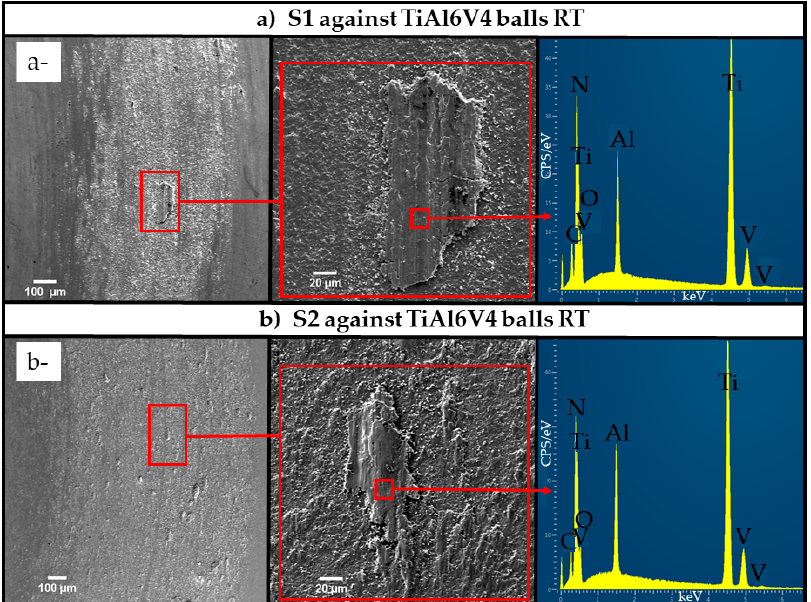
Figure 6. SEM micrographs of the wear tracks and wear debris, and the corresponding EDS analysis for the ( a ) reference and ( b ) Ag-alloyed coatings tested at RT against TiAl6V4 balls.